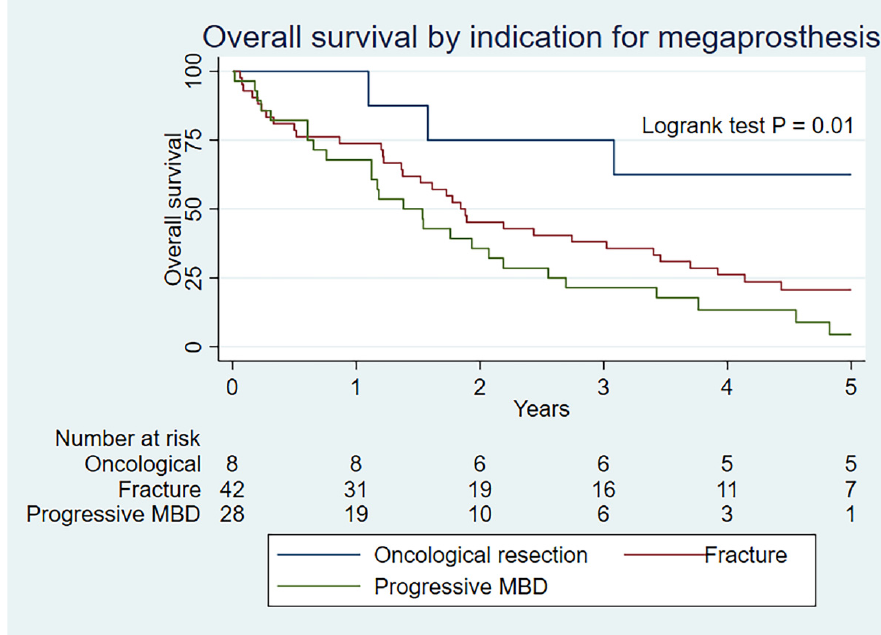
Figure 3. Kaplan–Meier rate of overall survival by indication group.